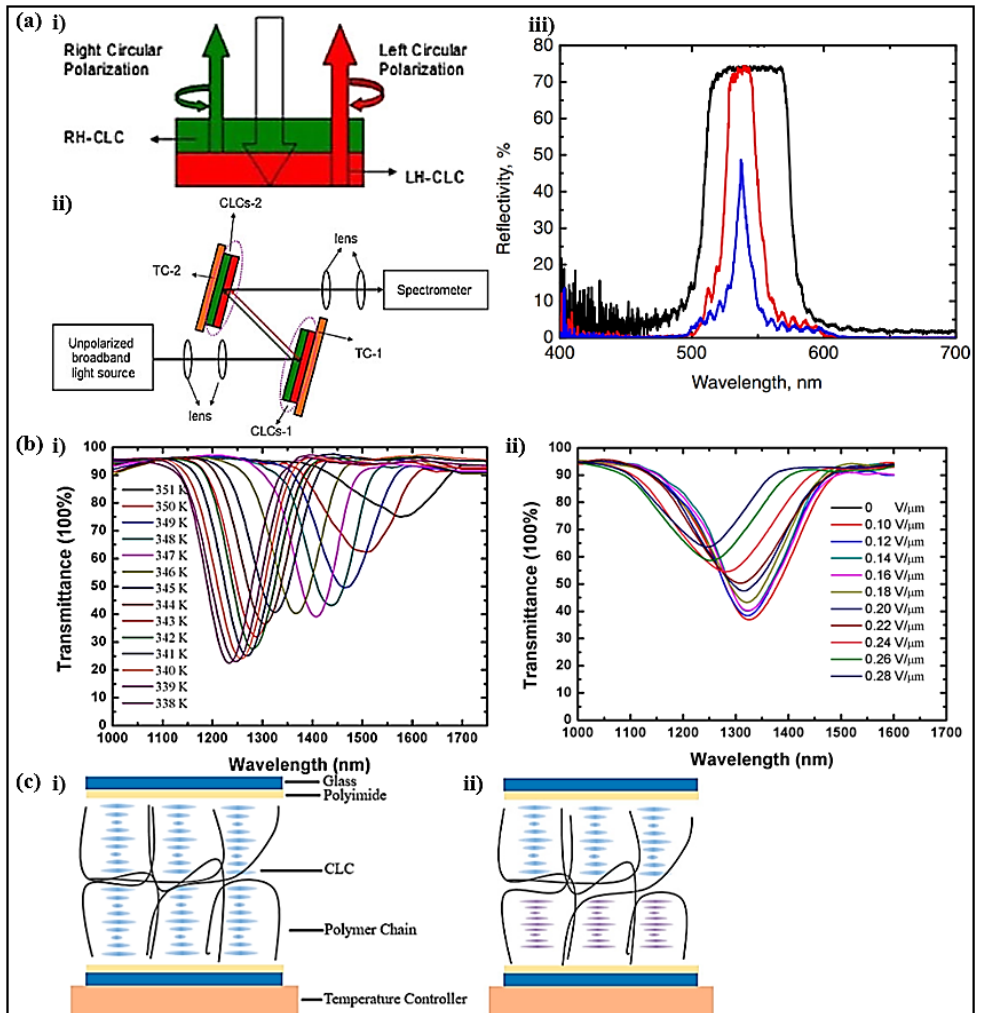
Figure 3. ( a ) i) Combination of RH-CLC and LH-CLC. ii) Schematic diagram of the experiment Figure 3. ( ai ) Combination of RH-CLC and LH-CLC. ( aii ) Schematic diagram of the experiment